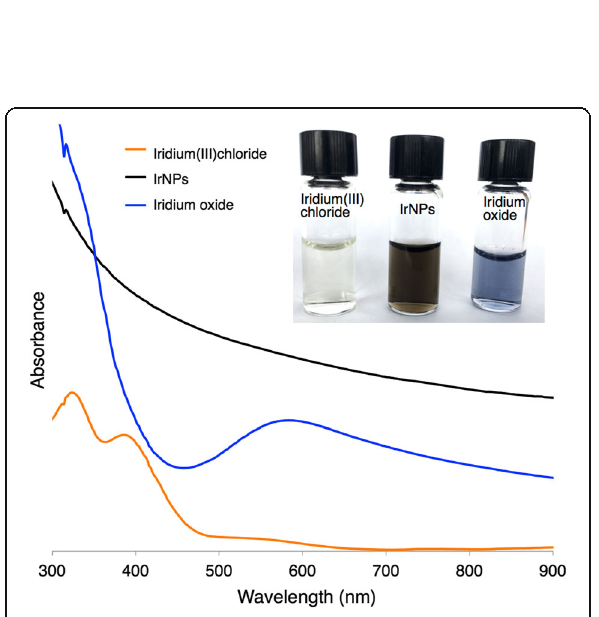
Fig. 2 Iridium(III) chloride appears pale yellow with absorbance peaks at 324 and 386 nm. IrNPs are broad-spectrum absorbers and appear black. Iridium oxide (predicted), produced from oxidized IrNPs treated in a basic solution, appears blue-purple purple with an absorbance peak at 584